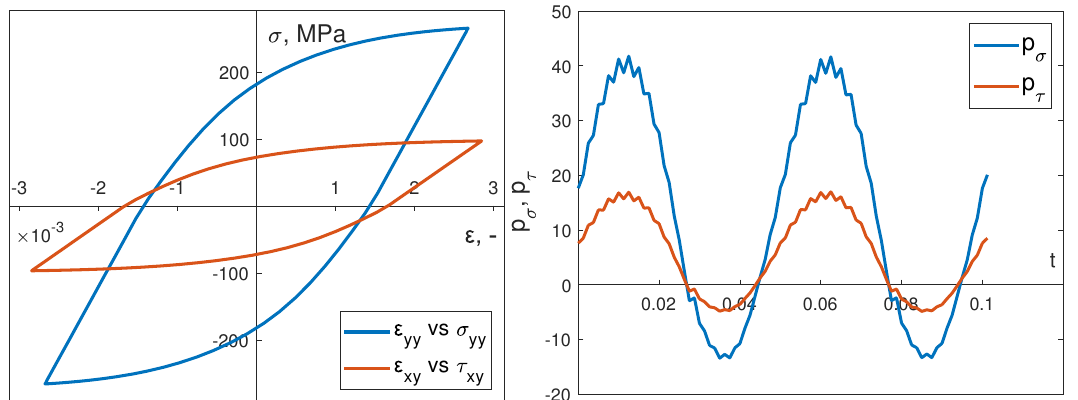
Figure 9. Stabilized calculated hysteresis loops for kinematic in-phase load and calculated instantaneous power (bending) p σ and torsion p τ .